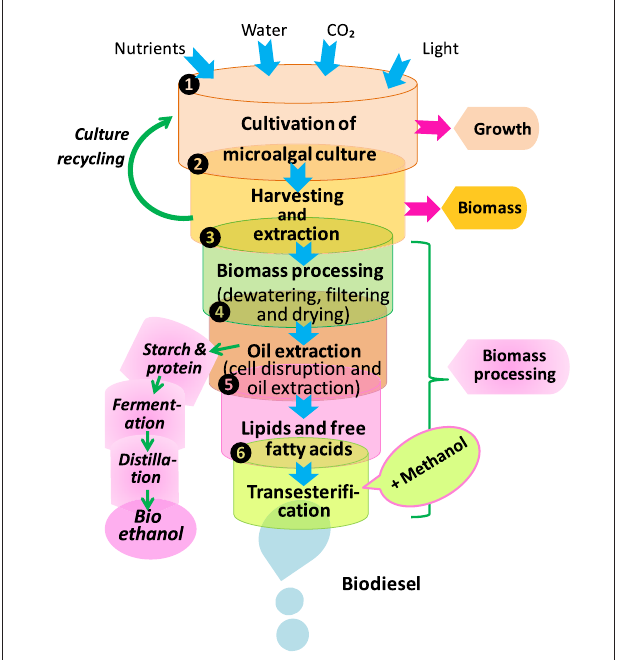
FIGURE 8 | Processes of biodiesel and bioethanol production from microalgae (modified from Dragone et al., 2010).